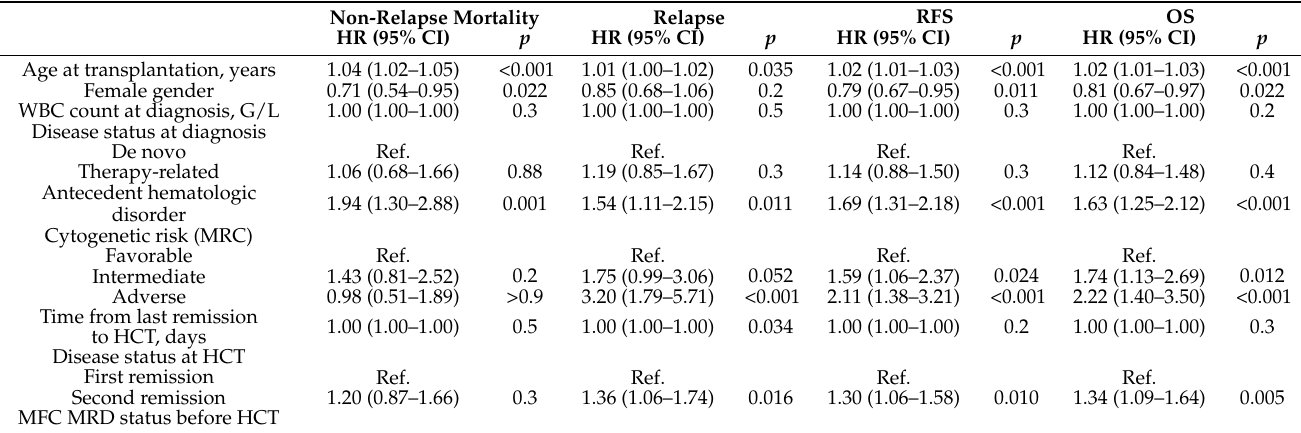
Table 2. Univariable regression models of study